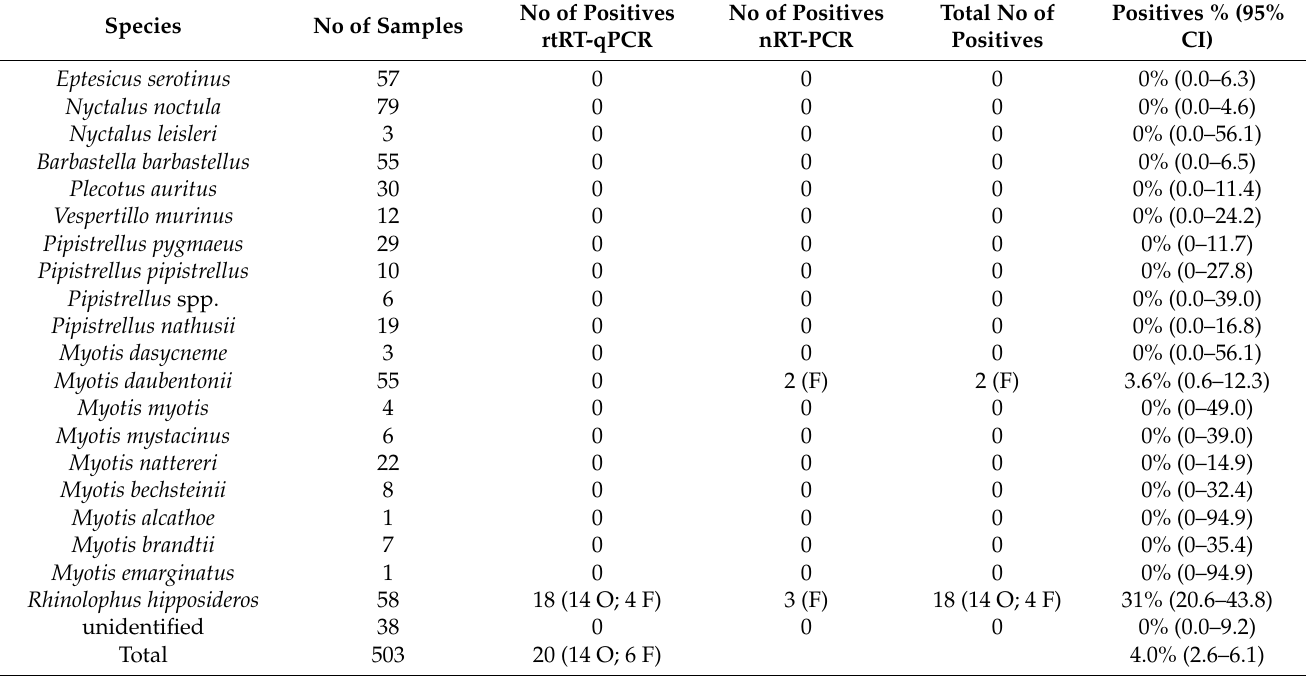
Table 1. The prevalence of BtCoVs in different bat species included in the study. O—oral swabs;